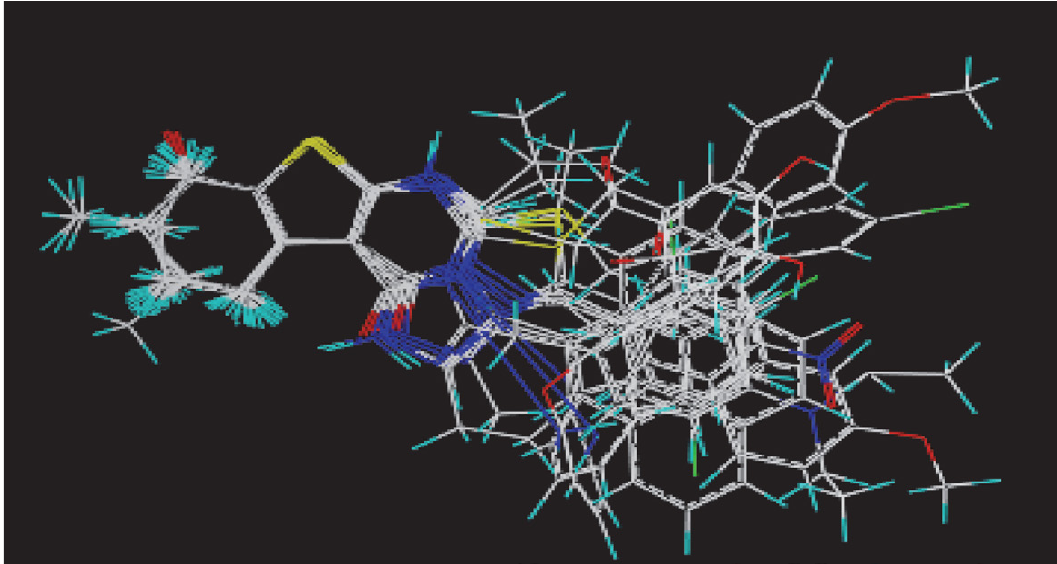
Fig. 2. 3D-QSAR structure superposition and alignment of training and test